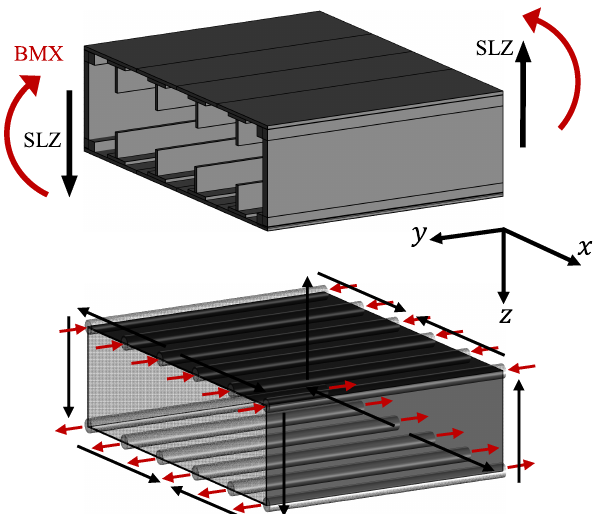
Figure 5. Load idealization. Top: bending moment (BMX) and shear force (SLZ) equilibrium on a single bay. Bottom: modified boom method to obtain the distributed loads of each representative